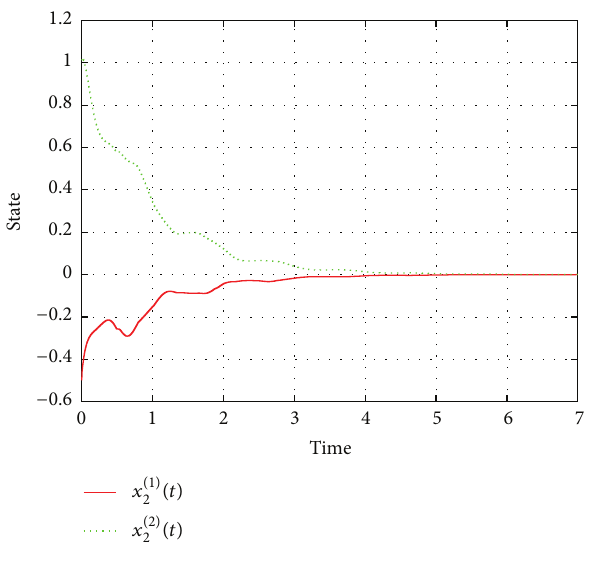
Figure 2: Time histories of 𝑥 2 (𝑡) .